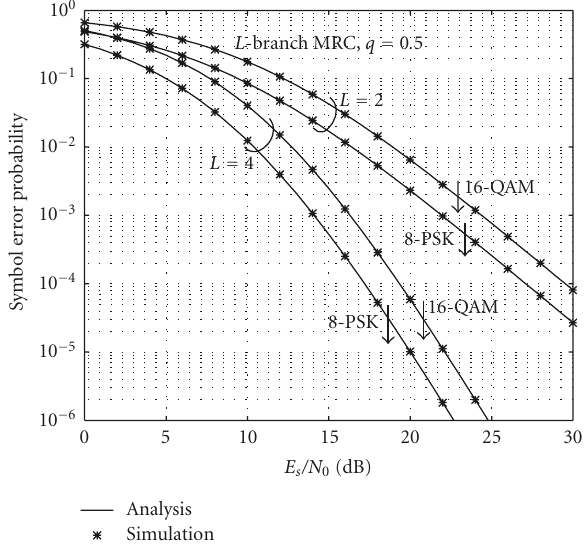
Figure 1: Symbol error probability of 8-PSK and 16-QAM versus E s /N 0 for L -branch MRC in SIMO Nakagami- q fading channels. q = 0 . 5, L = 2 and 4.